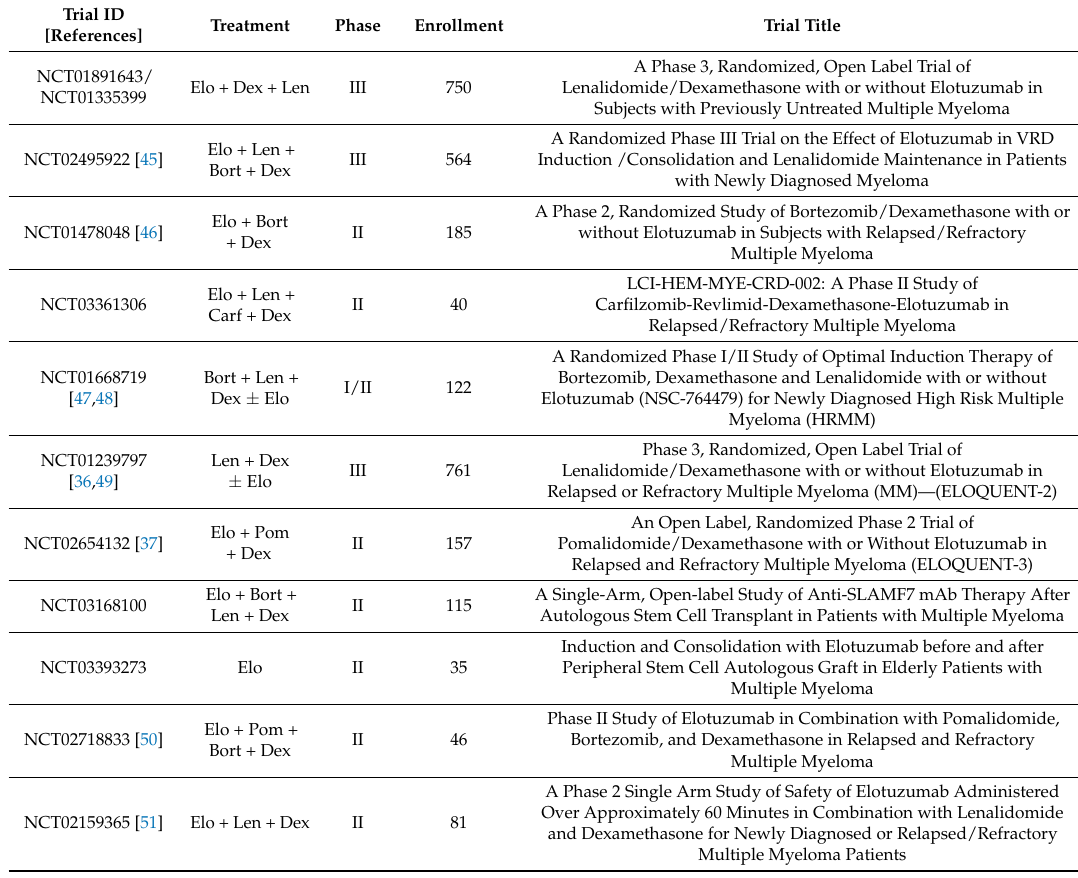
Table 3. Selected Active Trials of Elotuzumab in